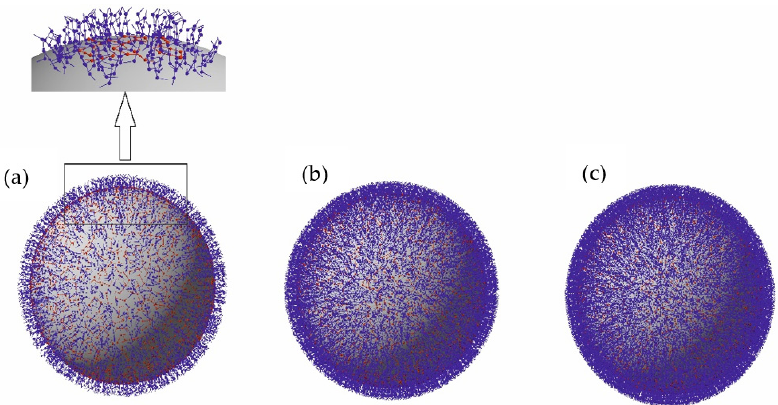
Figure 4. The fibrinogen coronas at LS particles derived from the RSA modeling for 0.01 mol L − 1 NaCl, pH 3.5 (simultaneous side-on and end-on adsorption). ( a ) - N = 1550 µ m − 2 ( Γ = 0.87 mg m − 2 ), ( b ) - N = 3900 µ m − 2 ( Γ = 2.2 mg m − 2 ), ( c ) - N = 5100 µ m − 2 ( Γ = 2.8 mg m − 2 ), the molecules adsorbed side-on are marked in red and the end-on adsorbed molecules are marked in blue.